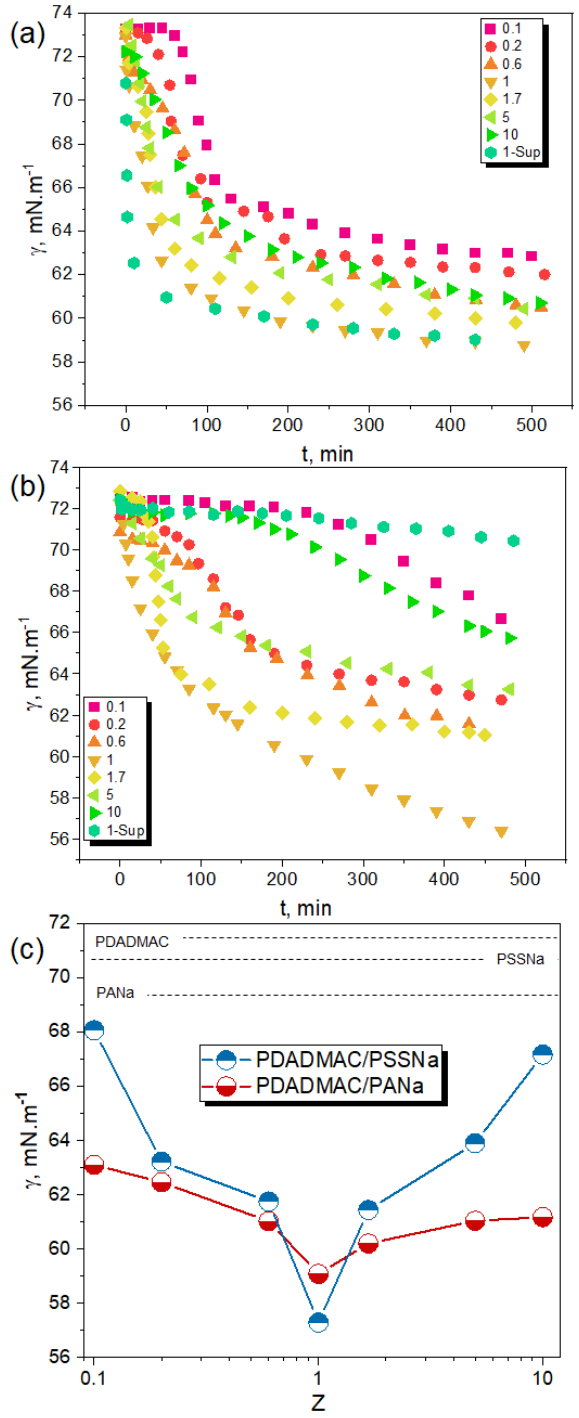
Figure 5. Dynamic surface tension ( γ ) of PDADMAC/PANa ( a ) and PDADMAC/PSSNa ( b ) PEC suspensions at different molar charge ratios (Z). Variation of γ obtained after 500 min as function of Z for the two PEC systems ( c ). PECs were prepared from PE solutions at 18.6 mM and pH 10 and rapidly analyzed after preparation. 1-sup in the ( a , b ) legend refer to the surface tension ( γ ) of the supernatant after the macroscopic phase separation occurring at Z = 1 for both systems. Dashed lines correspond to the surface tension of individual